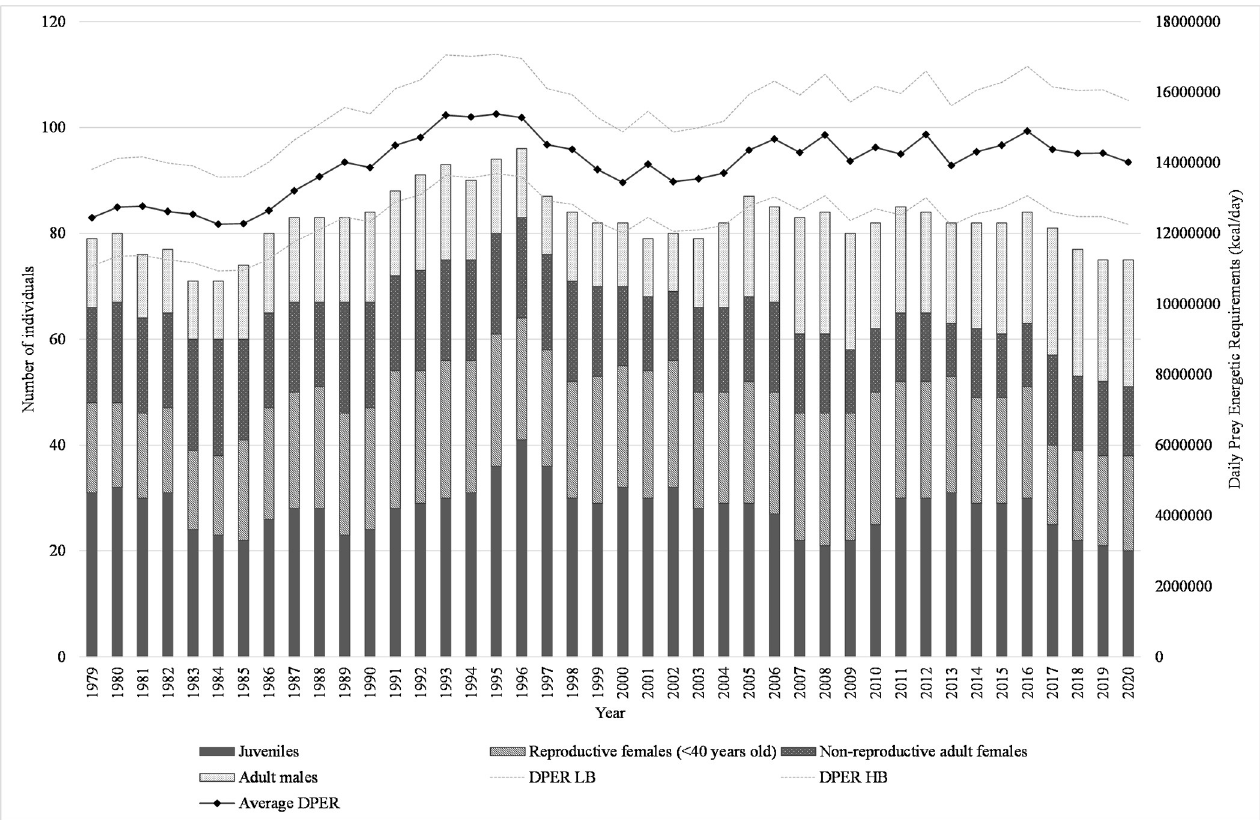
Fig 2. Number of individuals (stacked columns) and associated average daily prey energetic requirements (solid line) for the SKRW population from 1979 to 2020. The dashed lines represent the higher and lower bounds of the DPER estimates.